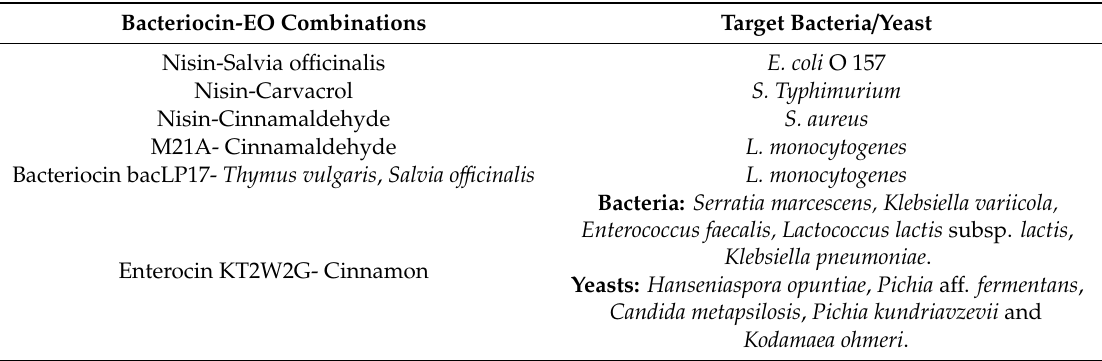
Table 4. Antimicrobial activities of bacteriocin-essential oil (EO) combinations. Bacteriocin-EO